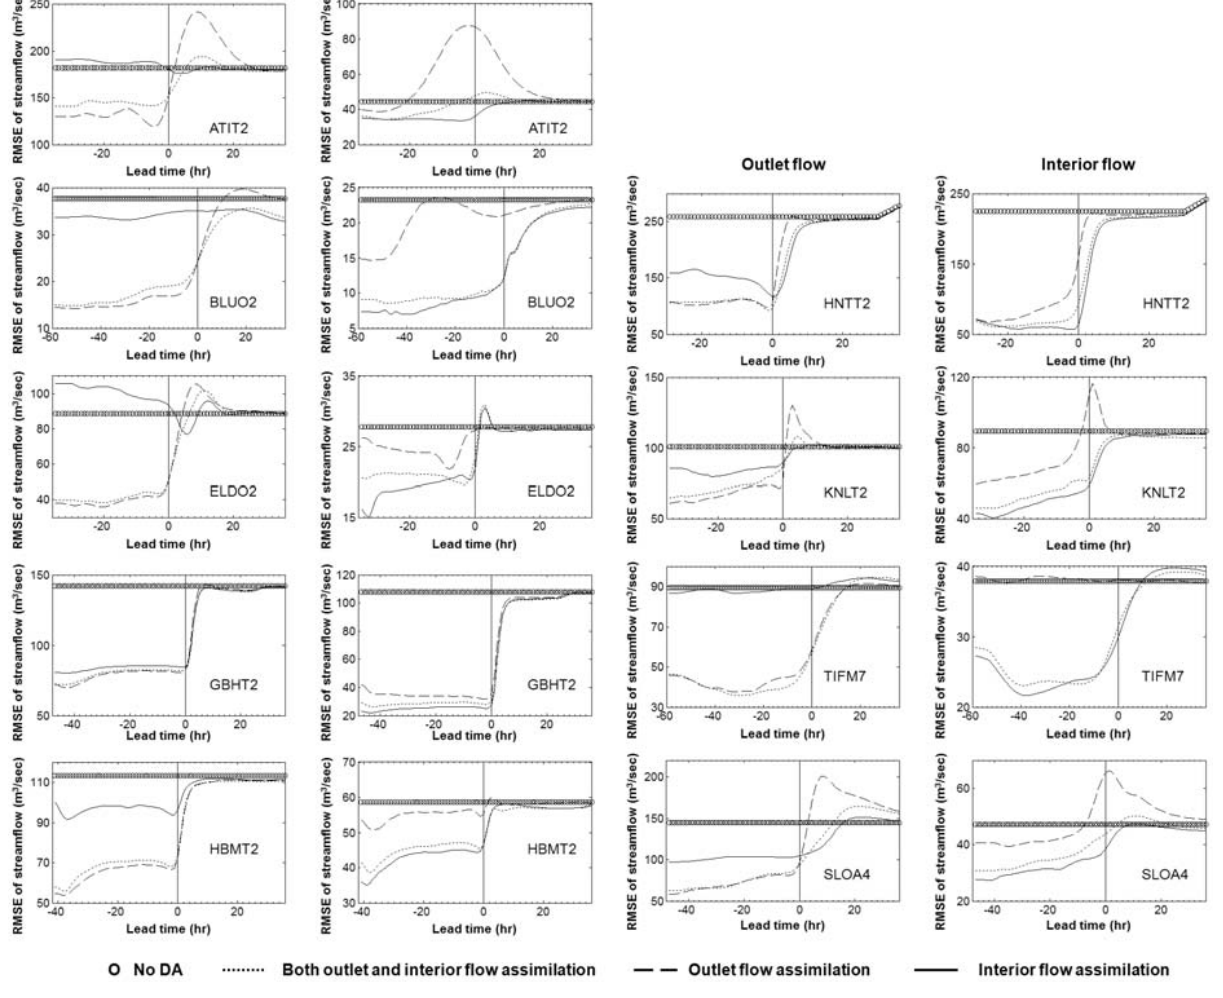
Fig. 10. RMSE of streamflow vs. lead hour where the lead hour is negative within the assimilation window.